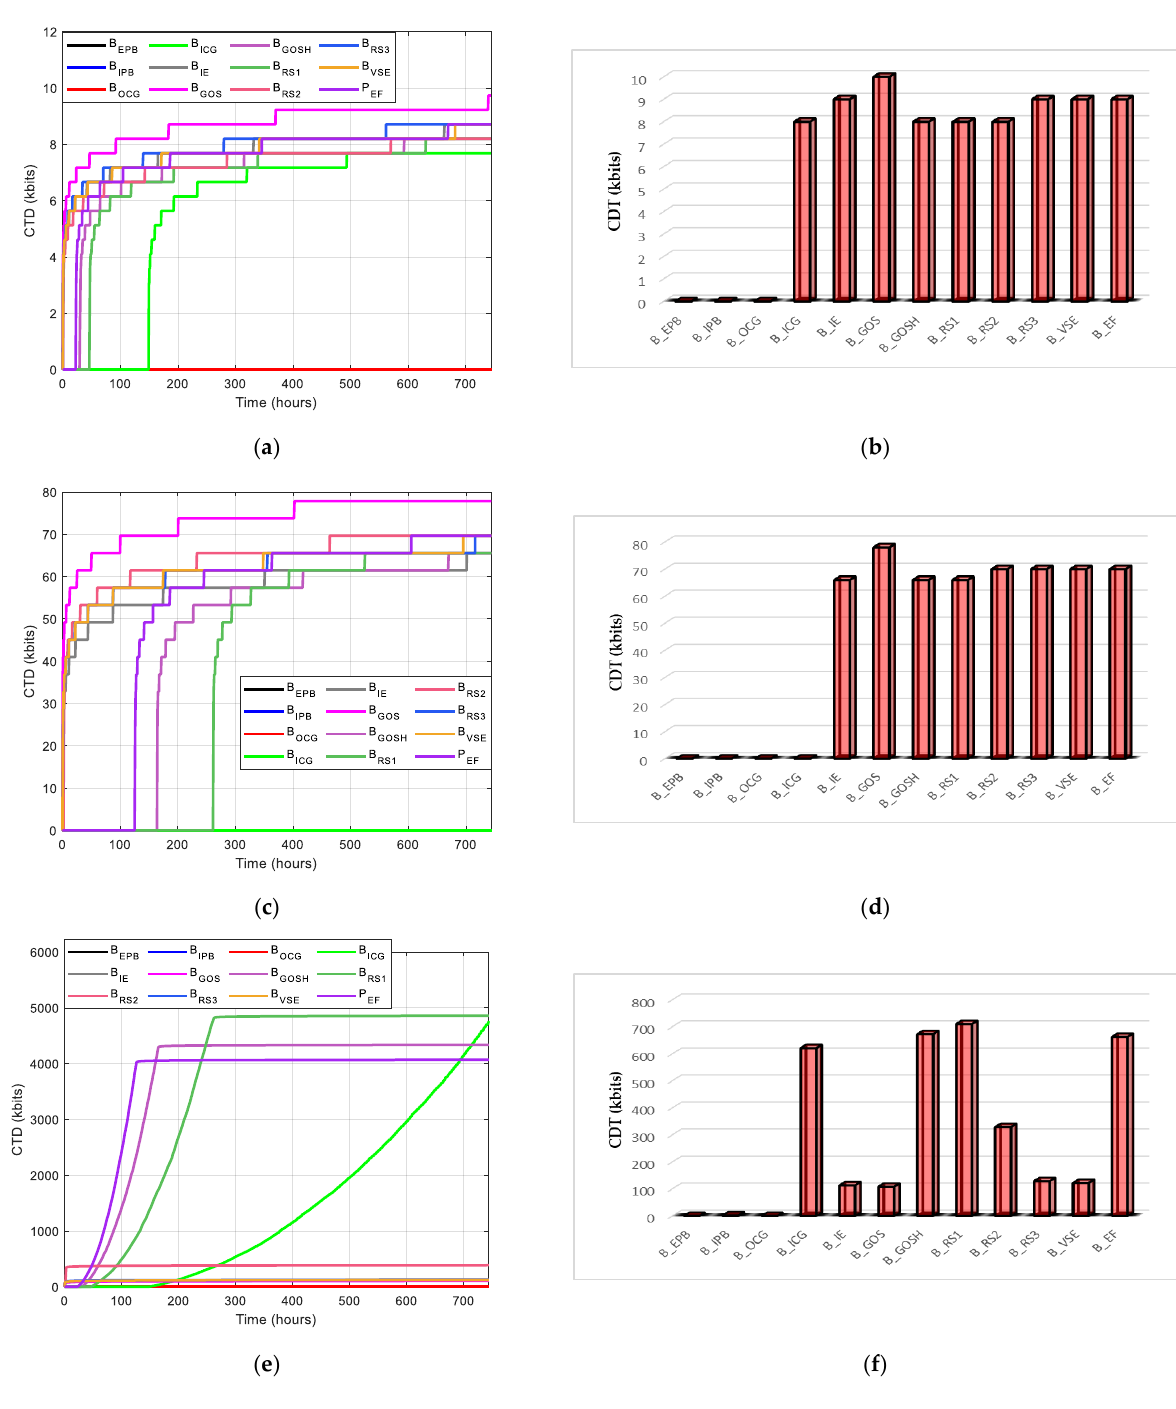
Figure 12. Performances DSMP. ( a ) Cumulated transmitted data for 𝑏 𝑚𝑖𝑛 = 512 bits . ( b ) Quantity of data transmitted by each node during the month for 𝑏 𝑚𝑖𝑛 = 512 bits . ( c ) Cumulated transmitted of data transmitted by each node during the month for b min = 512 bits. ( c ) Cumulated transmitted data for 𝑏 𝑚𝑖𝑛 = 4096 bits . ( d ) Quantity of data transmitted by each node during the month for 𝑏 𝑚𝑖𝑛 = 4096 bits . ( e ) Cumulated transmitted data for 512 bits ≤ 𝑏 𝑚𝑖𝑛 ≤ 4096 bits . ( f ) Quantity of data for b min = 4096 bits. ( d ) Quantity of data transmitted by each node during the month for data transmitted by each node during the month for 128 bits ≤ 𝑏 𝑚𝑖𝑛 ≤ 4096 bits . b min = 4096 bits. ( e ) Cumulated transmitted data for 512 bits ≤ b min ≤ 4096 bits. ( f ) Quantity of data transmitted by each node during the month for 128 bits ≤ b min ≤ 4096